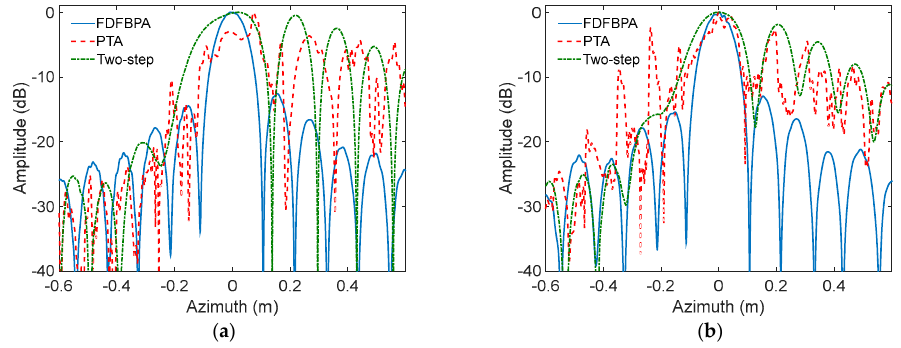
Figure 6. Azimuth impulse response curve comparison of FDFBPA, 25% overlapped PTA and Two-step MOCO: ( a ) 0 degree of squint angle; ( b ) 40 degrees of squint angle.